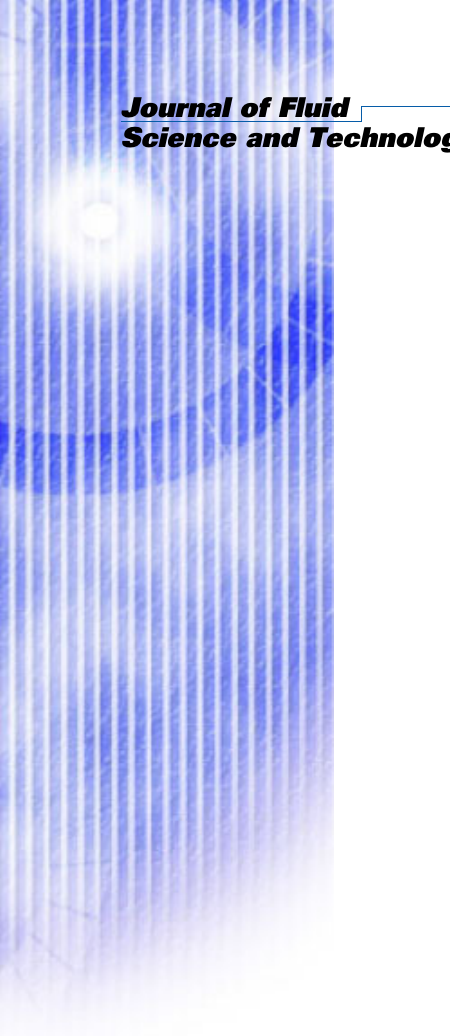
wing tip vortex trailing from a NACA0012